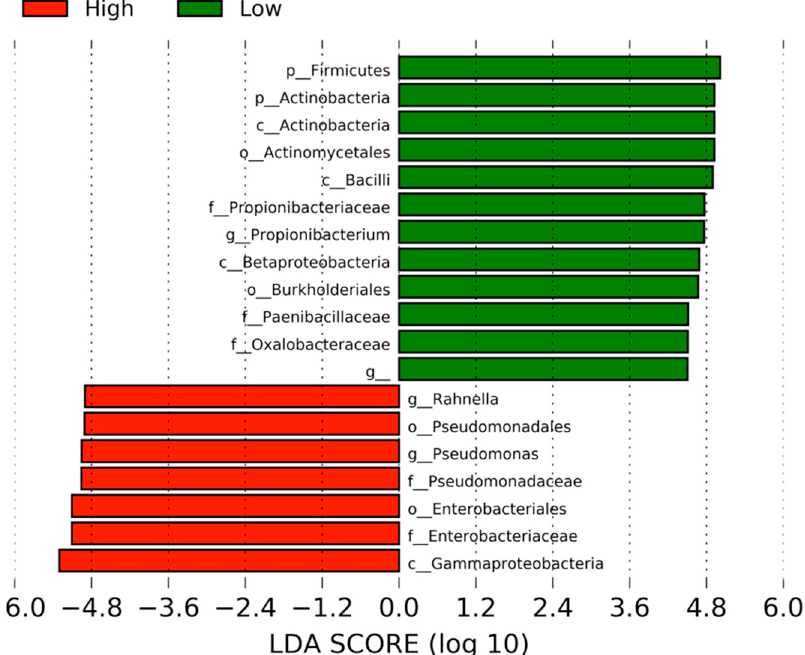
Figure 3. Differentially abundant clades between the high- and low-activity samples of A. sinensis . The clades correlated with the High monocyte activity are shown in red, whereas those correlated with the Low activity are in green. The default linear discriminant analysis (LDA) threshold in Linear discriminant analysis effect size (LEfSe) is 2.0. The higher threshold makes the analyses more stringent.